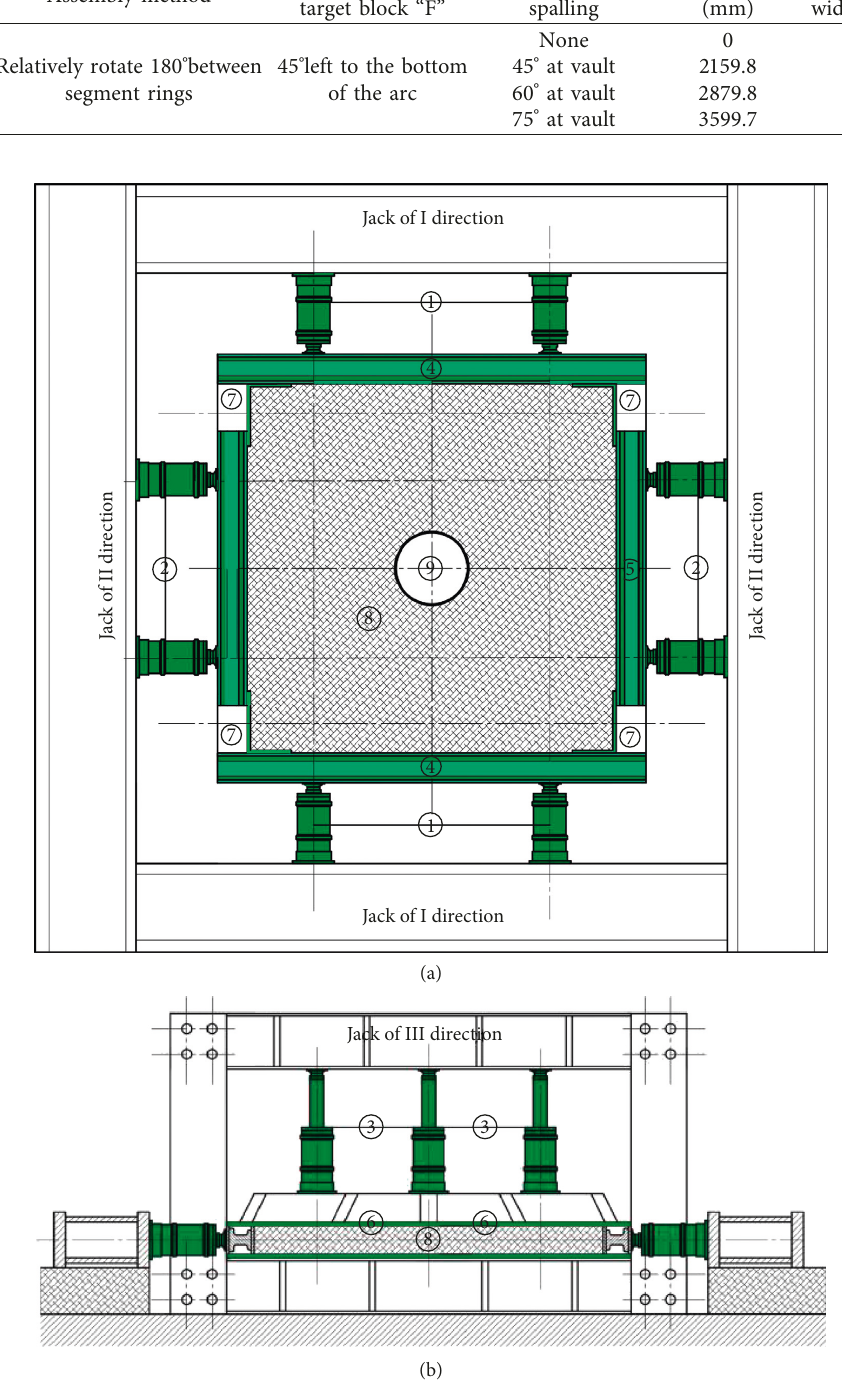
Figure 8: Loading device. (a) Vertical view of the loading device. (b) Lateral view of the loading device. ① Jack of direction I. ② Jack of direction II. ③ Jack of direction III. ④ Plate of direction I. ⑤ Plate of direction II. ⑥ Plate of direction III. ⑦ Loading plate. ⑧ Surrounding soil. ⑨ Model